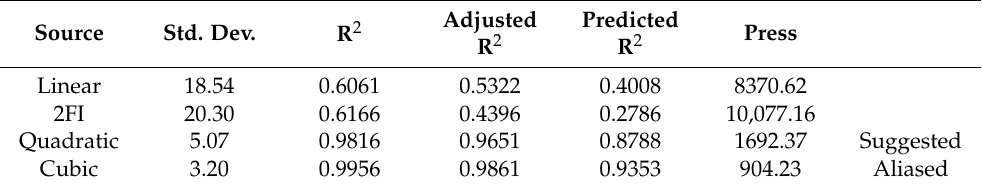
Table 6. The statistical magnitude of regression